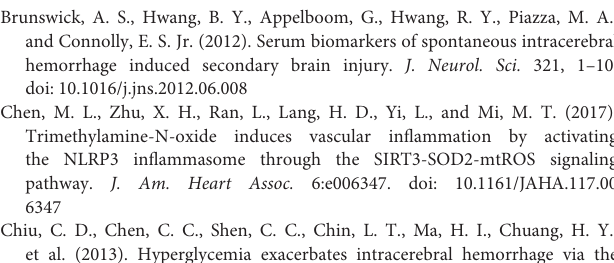
FIGURE S1 | Grouping information. FIGURE S2 | Stereological analysis. FIGURE S3 | Physiological parameters. FIGURE S4 | Sirt3 expression in HG and NG group at different time points after